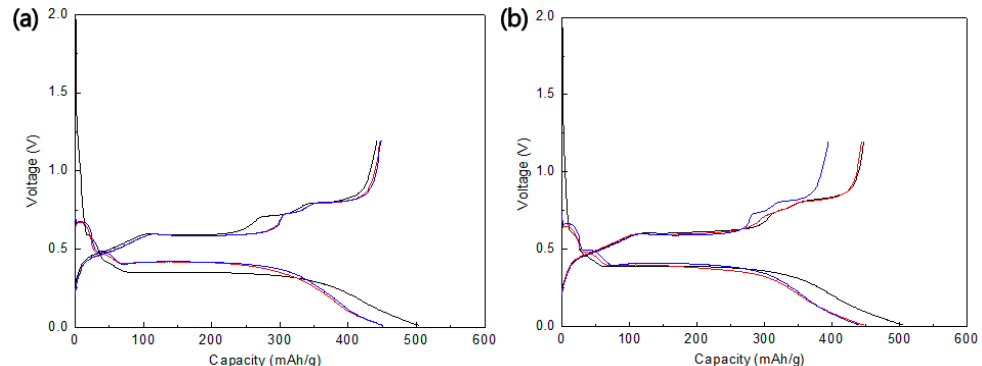
Figure 6. Discharge–charge curve of the ( a ) Sn and ( b ) Sn/TiNi electrode at 0.5 C in the voltage window of 0.01~1.2 V (vs. Li + /Li).